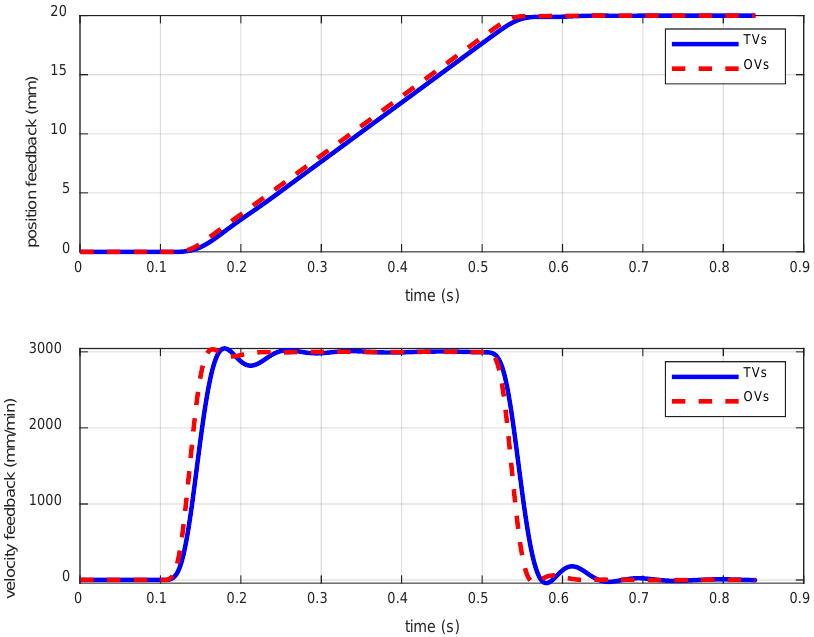
Figure 10. The simulation results of the velocity and position feedback with TVs and OVs.